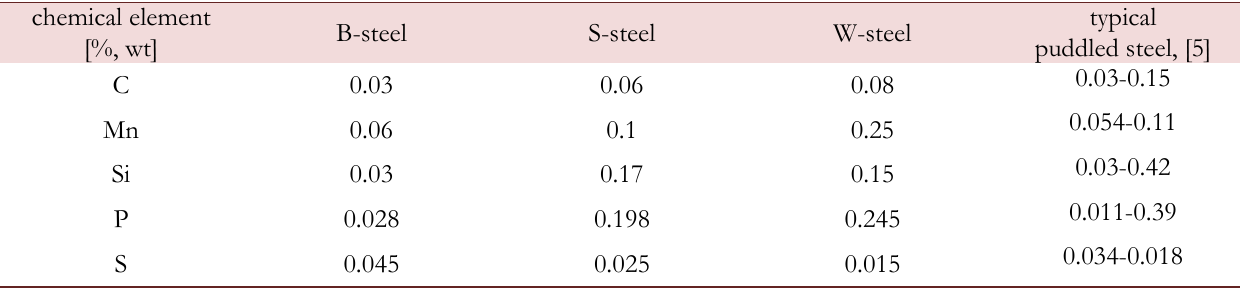
Table 1: Chemical composition of the investigated material